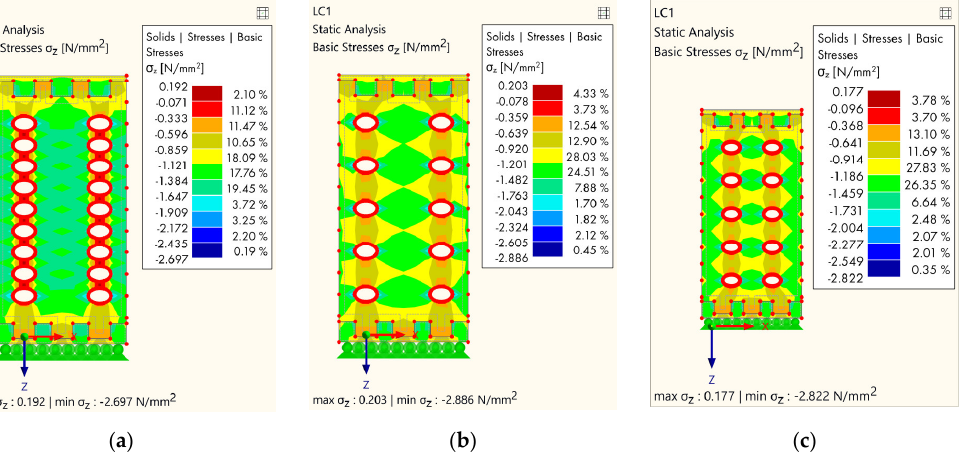
Figure 14. Results of FEM analysis—stress: ( a ) The central part without cavities; ( b ) the central part and each subsequent lamella without cavities; ( c ) the outer part and each subsequent lamella without holes.